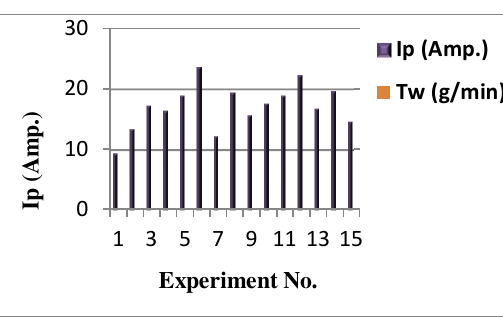
Fig. 9. Effect of current intensity on